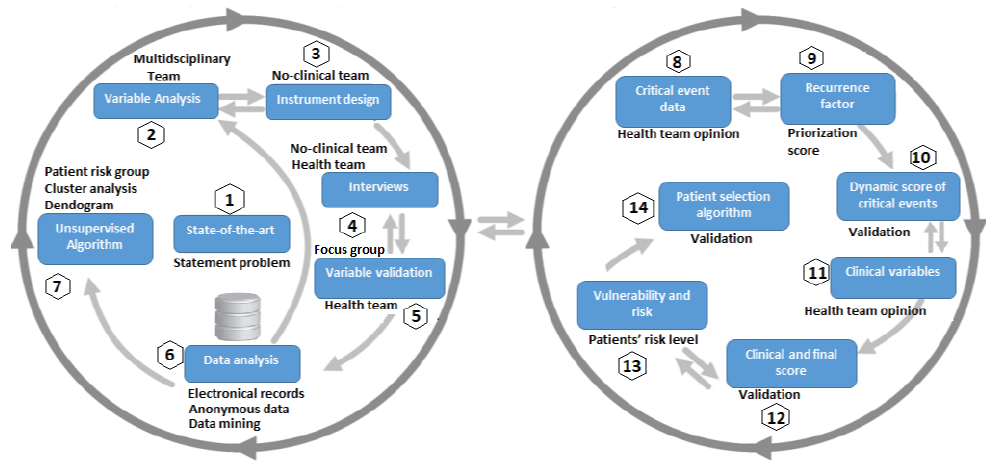
Figure 1. Visualization of the process and methodological design for the decision support